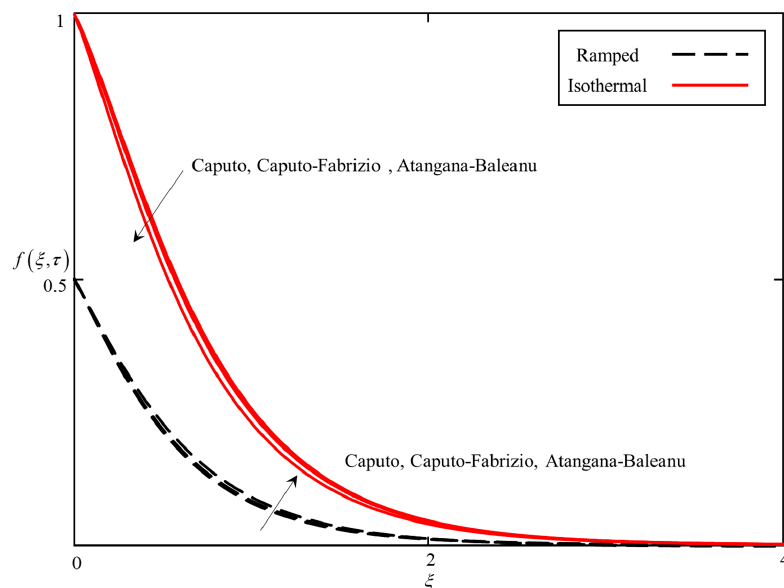
Figure 4. Comparison of the velocity field for Caputo, Caputo–Fabrizio and Atangana–Baleanu fractional derivatives, when α = 0.5, β = 0.5 φ = 0.04, λ 1 = 0.5, λ 2 = 0.5, M = 0.5, K = 0.5 Pr = 21, and Gr = 5.0.